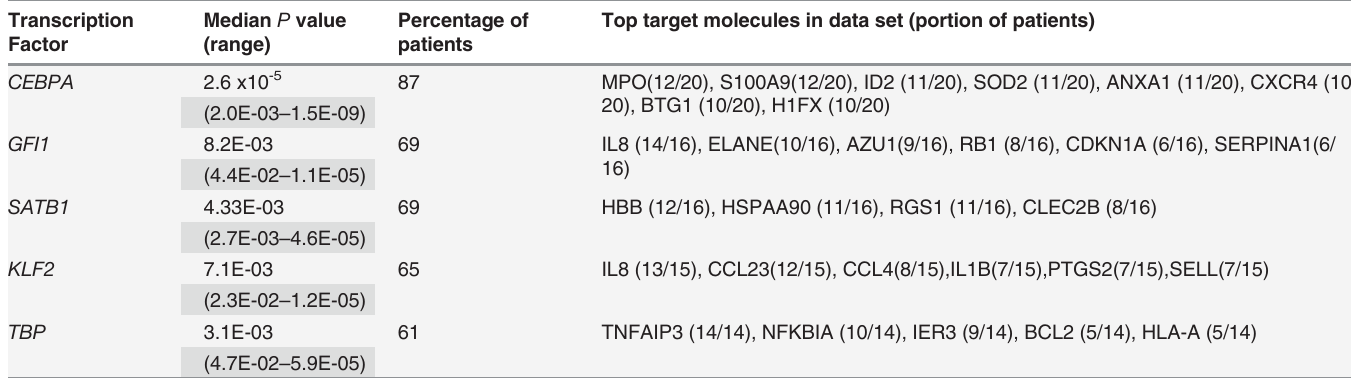
Table 2. Top list of transcription factors that regulate differentially expressed genes in paired diagnosis and relapsed samples, ranked by